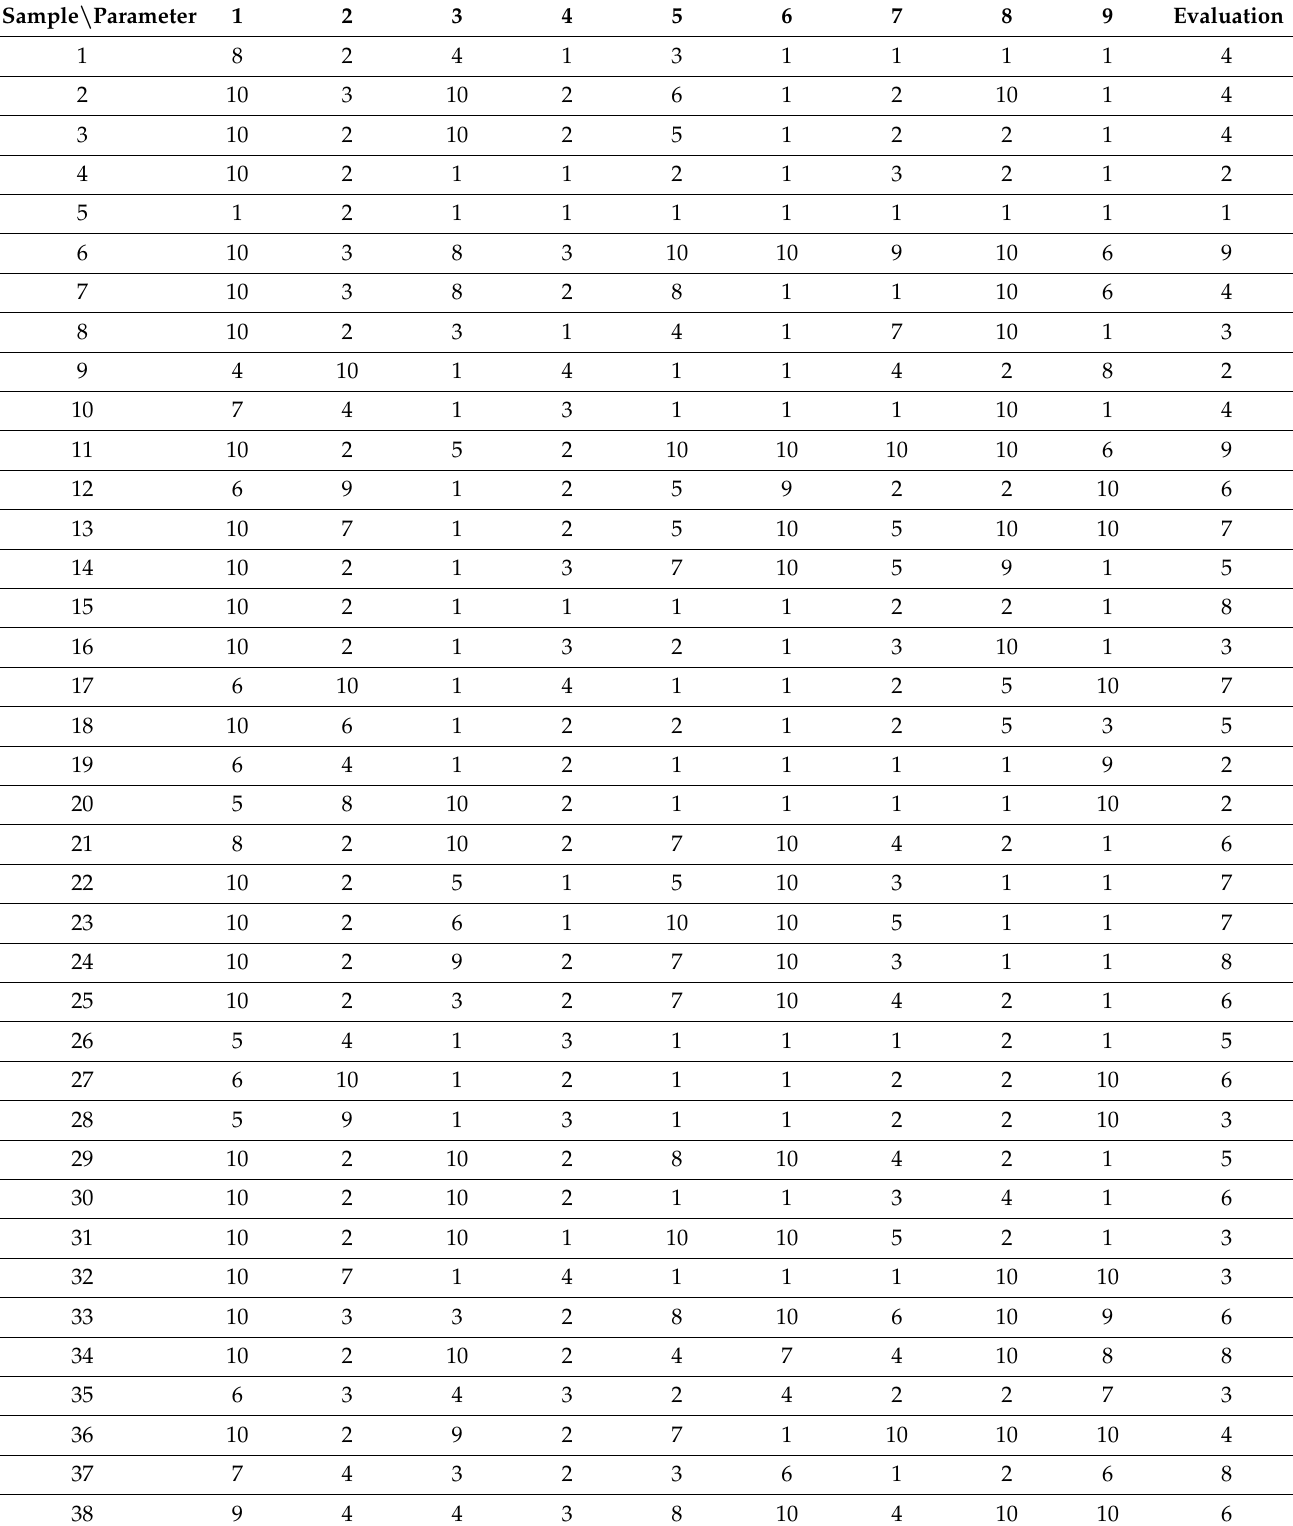
Table A2. Scaling of the parameters measured according to the collected set of